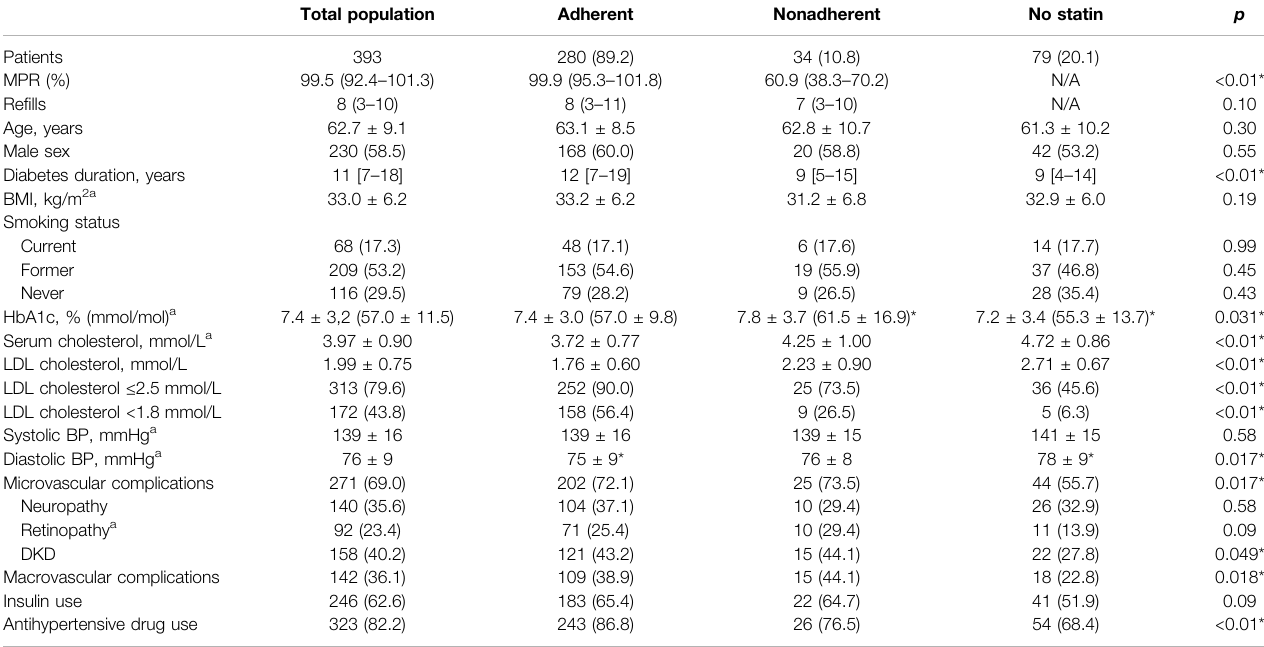
TABLE 1 | Baseline characteristics by overall adherence in the DIALECT-1 population.